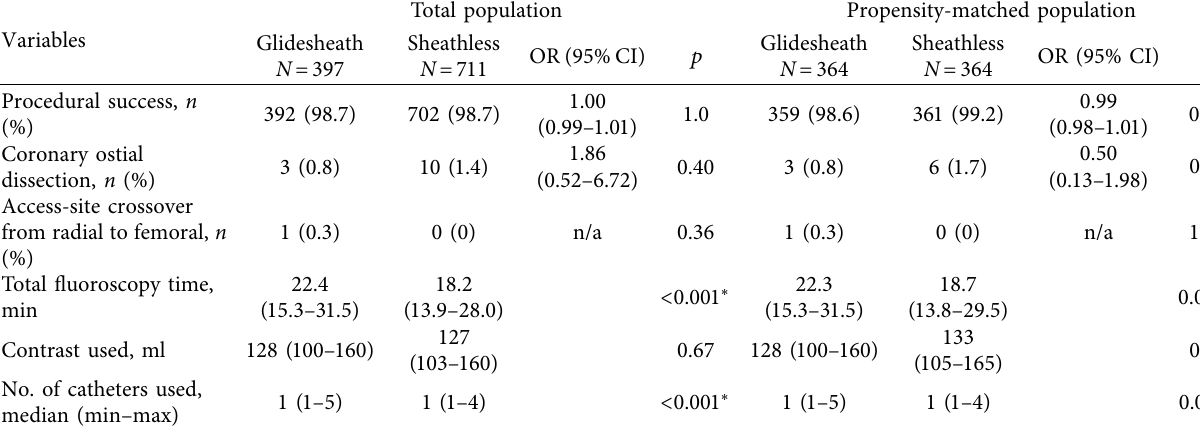
Table 3: Procedural